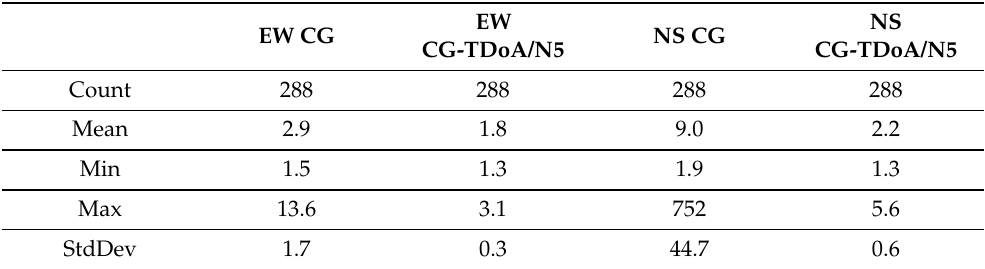
Table 6. Residential street (9-m-high buildings) scenarios: statistical analysis of the PDOP for GNSS- alone (CG) and GNSS + TDoA from five 5G base stations (CG-TDoA/N5). EW = east-west street; NS = north-south